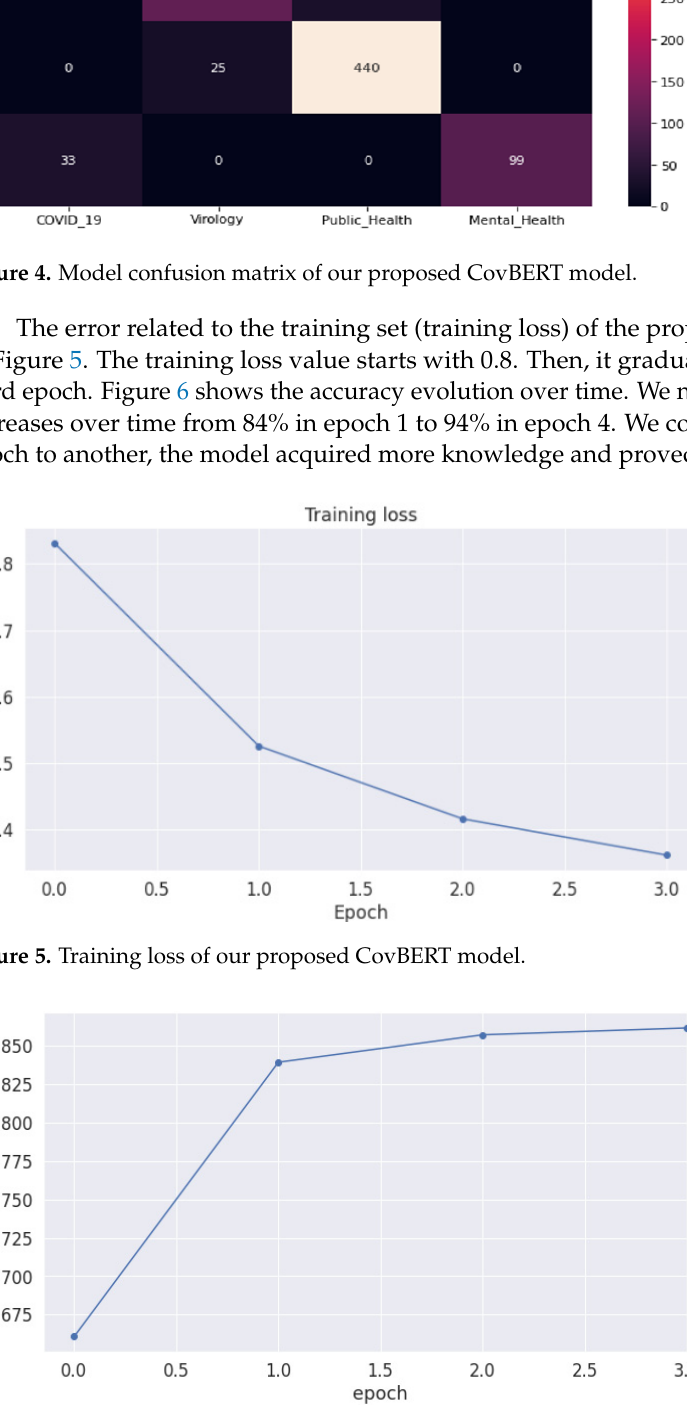
Figure 3. CovBERT model accuracy.